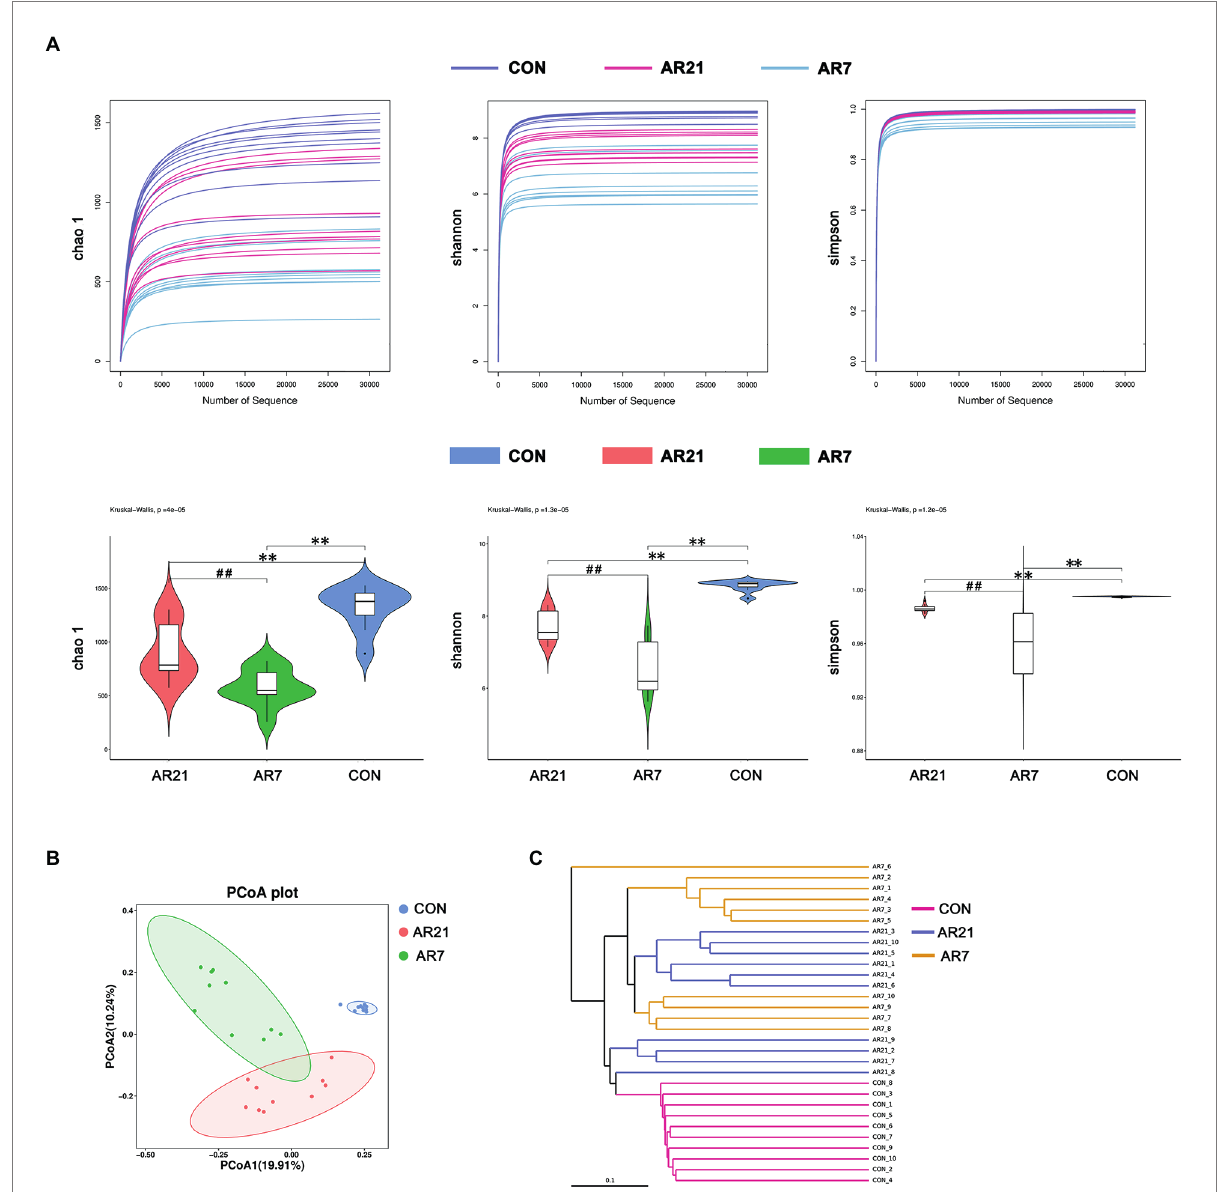
FIGURE 2 Effects of artificial rearing on the abundance and diversity of colonic microbiota in piglets. (A) The alpha diversity determined by Chao 1, Shannon, and Simpson. (B) The principal coordinate analysis (PCoA) score based on the unweight UniFrac distance. (C) UPGMA hierarchical clustering analysis based on the unweighted UniFrac distance. Data are presented with mean ± SD. ** p < 0.01 versus the CON group; ## p < 0.01 versus the AR21 group. n = 10